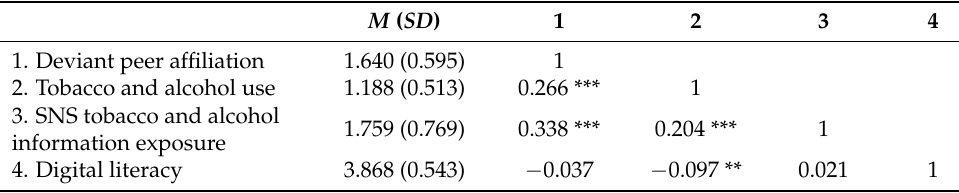
Table 1. Descriptive statistics and correlation analysis of